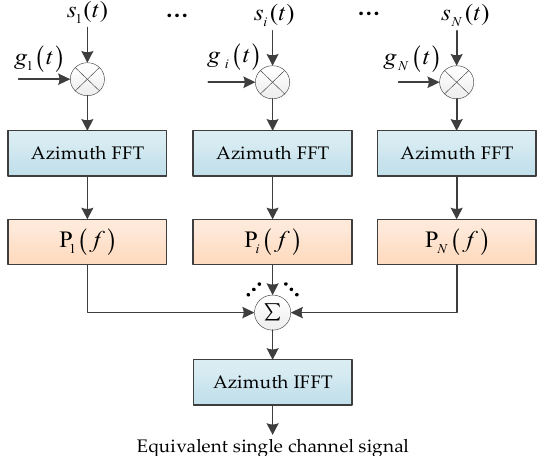
Figure 7. Flowchart of the improved 1D azimuth multichannel reconstruction method .